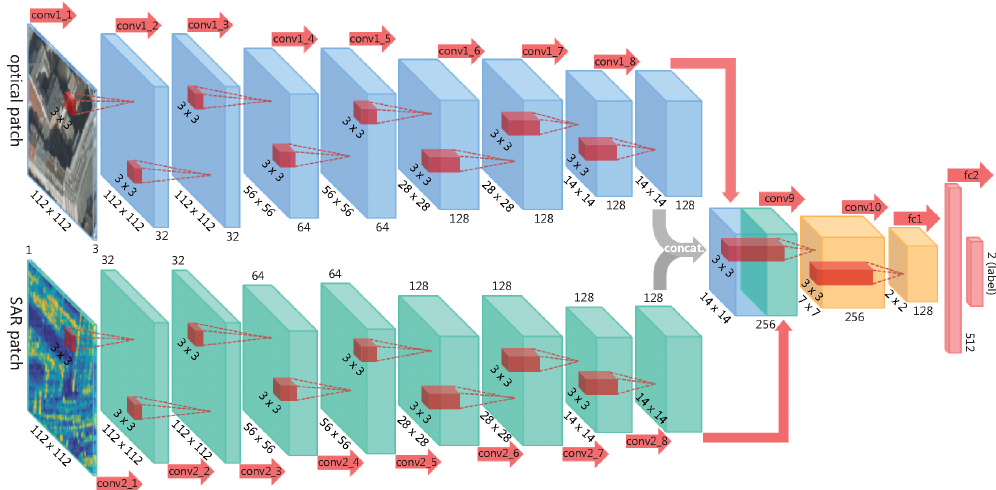
Figure 8. The pseudo-Siamese convolutional matching network proposed in [14]. The network attempts to predict the probability that the given input pair are corresponding in terms of the alignment of the center pixel in each patch. ( c (cid:13) 2018